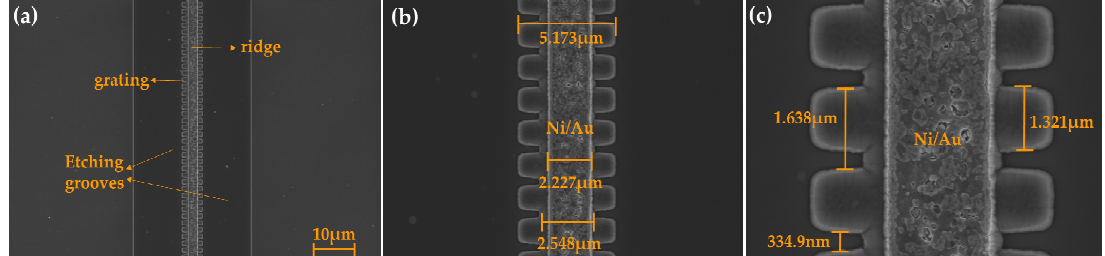
Figure 6 SEM images of a top view of the fabricated DFB laser diodes with 20th order sidewall gratings. ( a ) An overall view of the DFB LD with double etching grooves; ( b ) a low power and ( c ) a high power perspective of the ridge waveguide and the sidewall gratings along it.